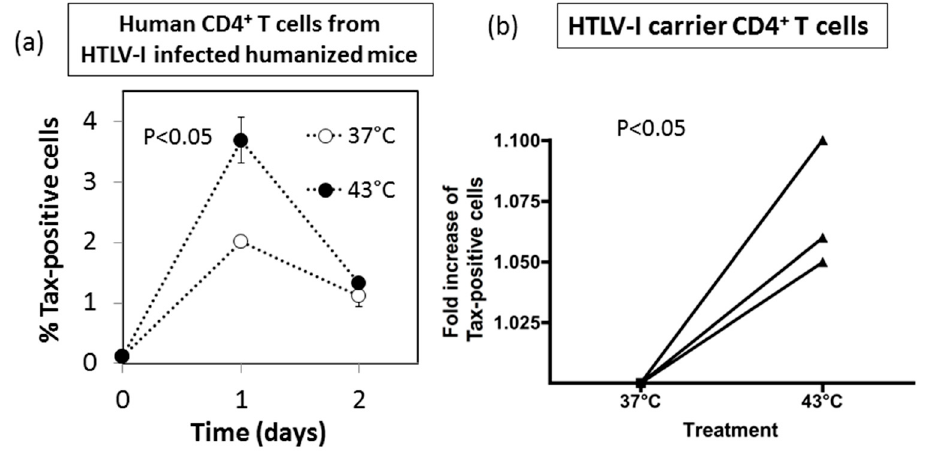
Figure 7. Effect of HS exposure on primary human CD4 + T cells infected with HTLV ‐ I: ( a ) NOD/SCID/ γ c null mice (NOG mice, n=3) were humanized by transplantation with normal human peripheral blood mononuclear cells (PBMCs) and infected with HTLV ‐ I (as described in Materials and Methods). After 2 weeks, cells within the peritoneal lavage were collected and either exposed to HS (black circle) or mock treated (open circle). These cells were cultured in triplicates and examined for the frequencies of Tax antigen expressing cells on day 0, 1 and 2. The values denote the means ± SE. * p <0.05; ( b ) Aliquots of diluted whole blood from three different HTLV ‐ I carriers were either exposed to HS (43 °C) or mock treated, and then cultured for 24 h. The gated population of CD4 + T cells was analyzed for the expression of Tax and gp46 antigens by FCM.